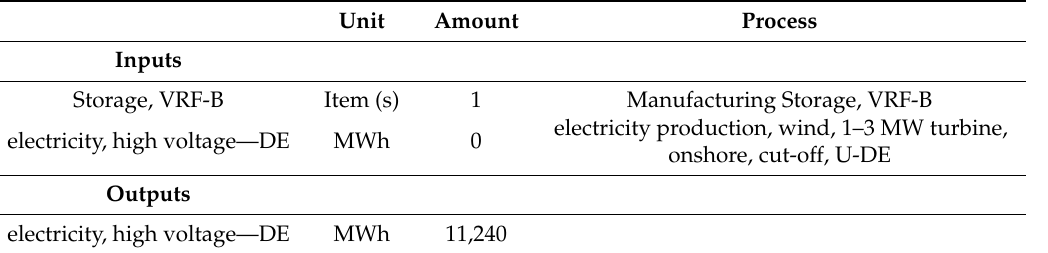
Table A23. Use Storage,